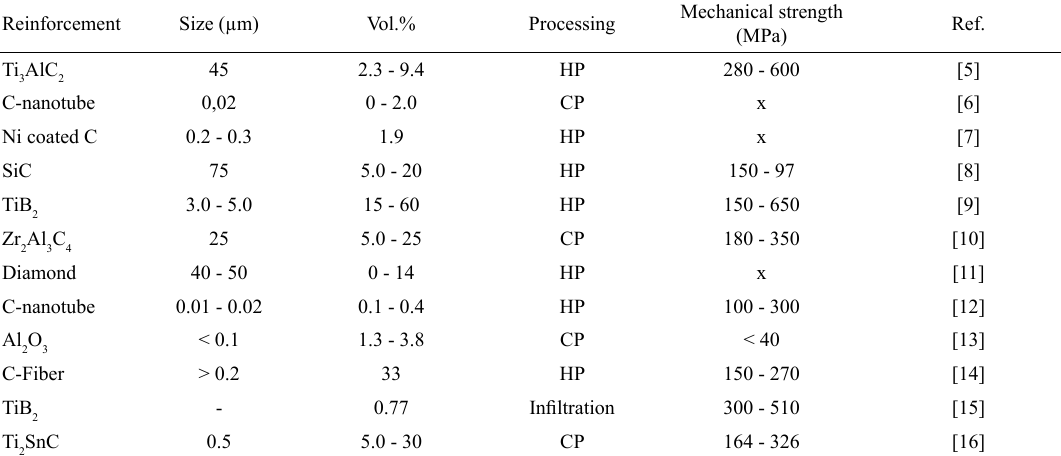
Table 1. Examples of ceramic materials used to produce copper matrix composites.